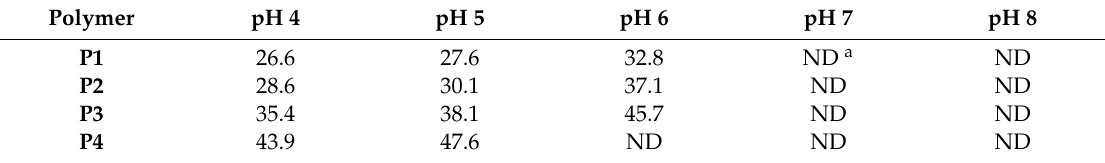
Figure 3. Transmittance of copolymer aqueous solutions ( a ) P1 , ( b ) P2 , ( c ) P3 , and ( d ) P4 . Here, red is pH 4, yellow is pH 5, green is pH 6, blue is pH 7, and violet is pH 8. Table 2. Lower critical solution temperature (LCST) values (°C) of copolymers.